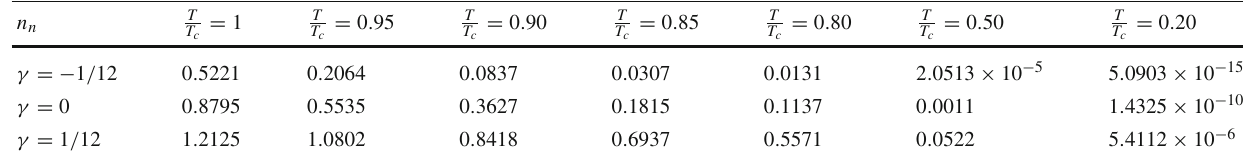
Fig. 3 Real and imaginary parts of AC conductivity σ yy in 6 derivative theory Table 5 The normal fluid density n n in the superconducting phase for the different temperature in 4 derivative theory ( γ 1 = 0)